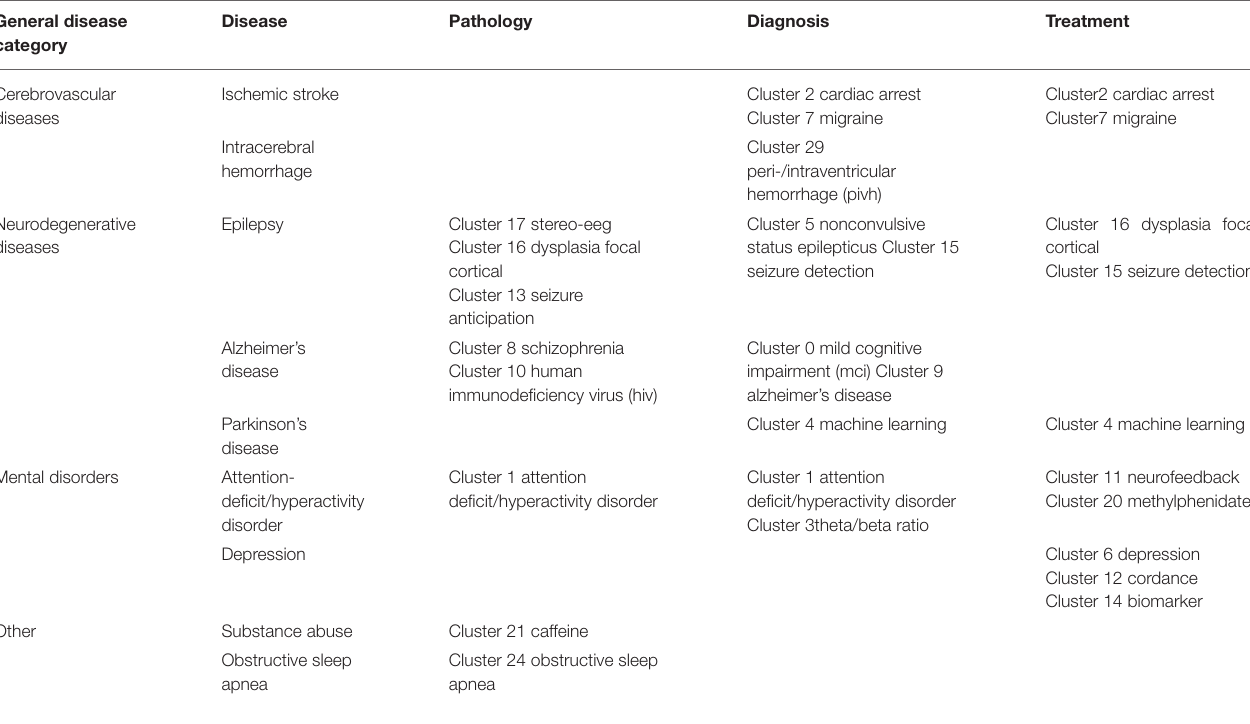
TABLE 4 | Research disease categories and domains retrieved from the co-cited reference clusters. General disease